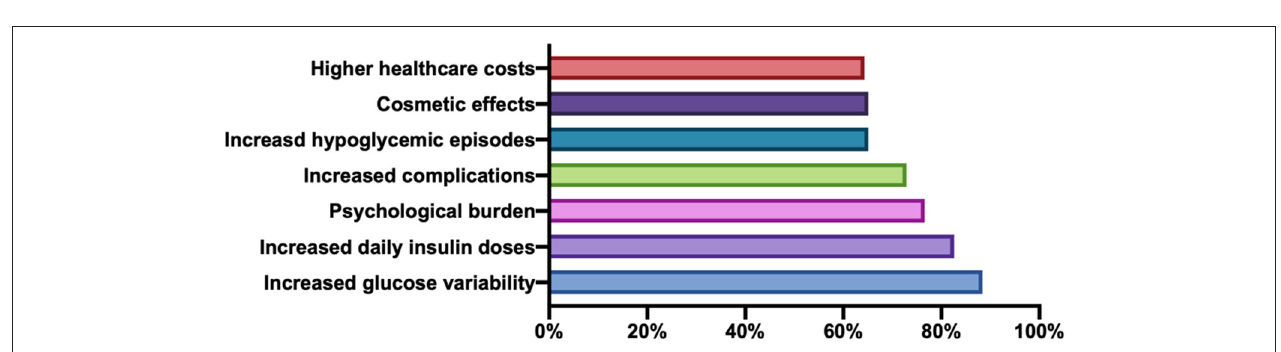
FIGURE 4 | Risk factors associated with lipohypertrophy.